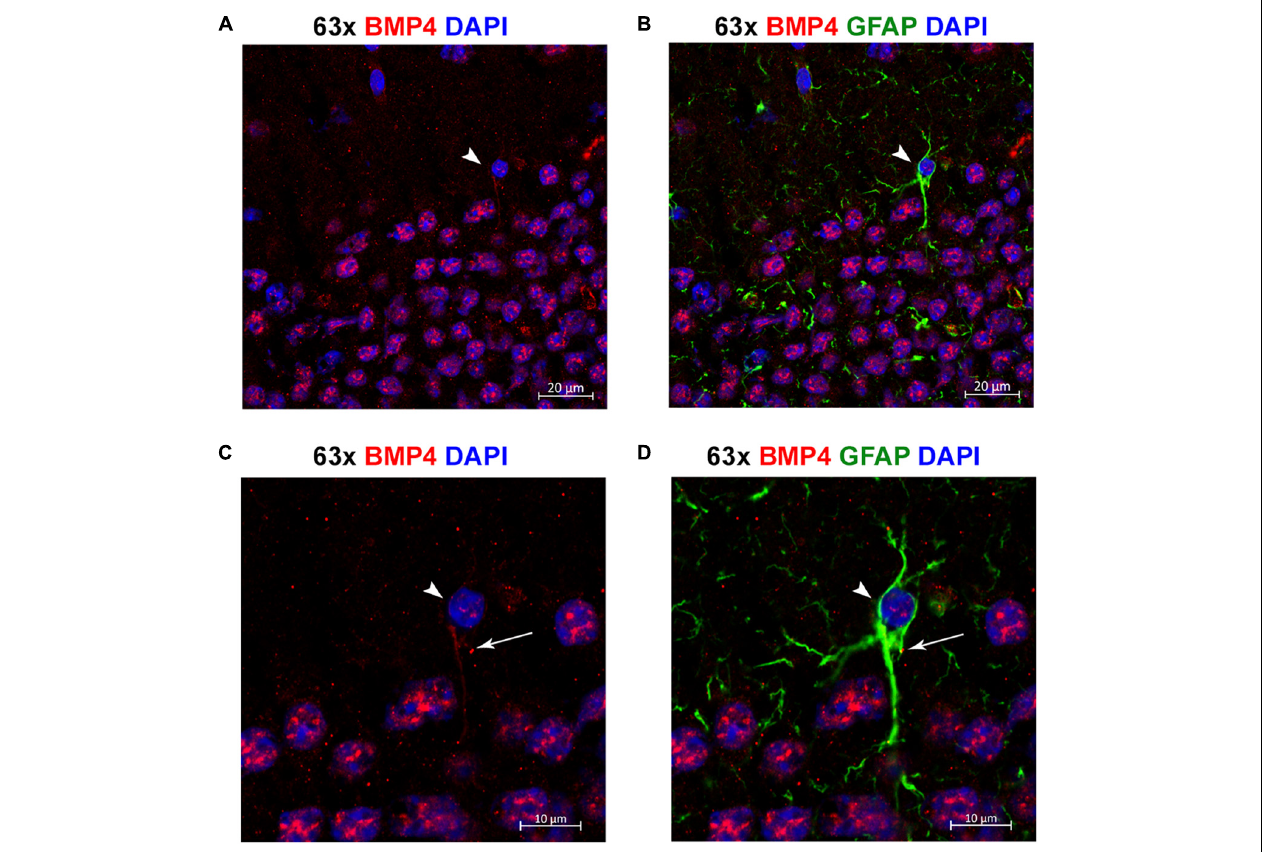
FIGURE 8 | Individual astrocytes express BMP4. (A,B) Confocal images identifying BMP4 staining in hippocampal astrocytes. Strong BMP4 labeling (red) is localized around the nuclei (blue) of hippocampal neurons, with diffuse and punctate labeling in the parenchyma and weaker labeling in a GFAP (green) positive astrocyte cell body (arrowhead). (C,D) Magnified images focused on the individual astrocyte from (A,B) exhibiting BMP4 labeling mainly localized to the area around the nucleus (arrowhead) with some labeling also present in processes (arrow). Scale bars = 20 µ m (A,B) , 10 µ m